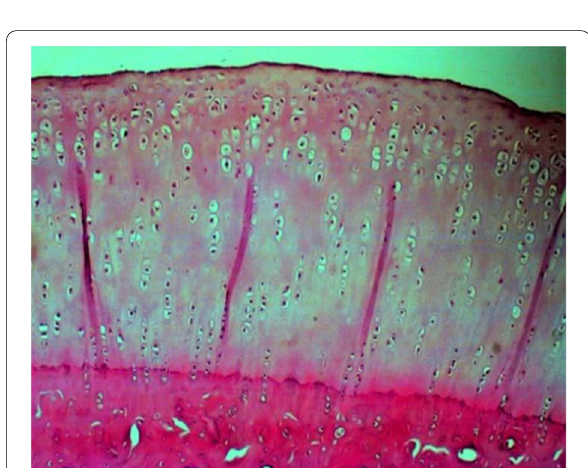
Fig. 5 Microscopic appearance in GH5 group showing normal and thicker cartilage